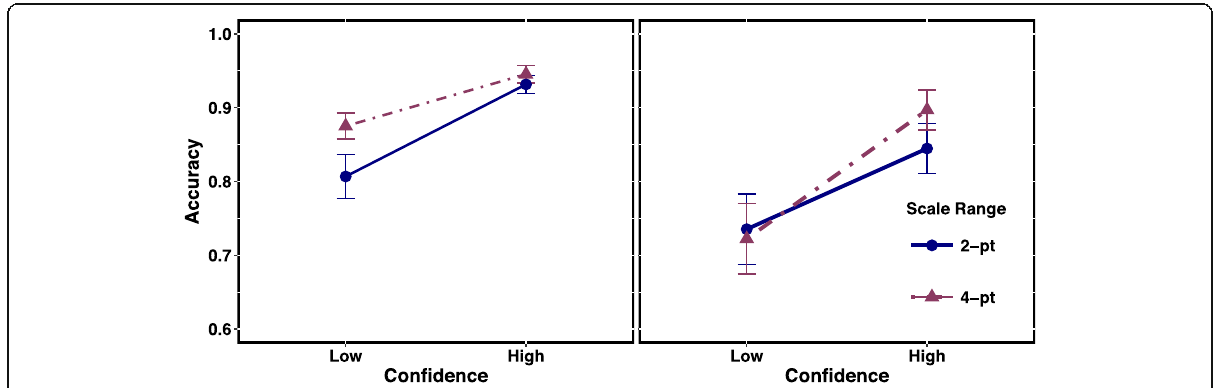
Fig. 2 Comparison of the 2-point scale to the 4-point scale for Set A ( left ) and Set B ( right ). Error bars indicate standard errors